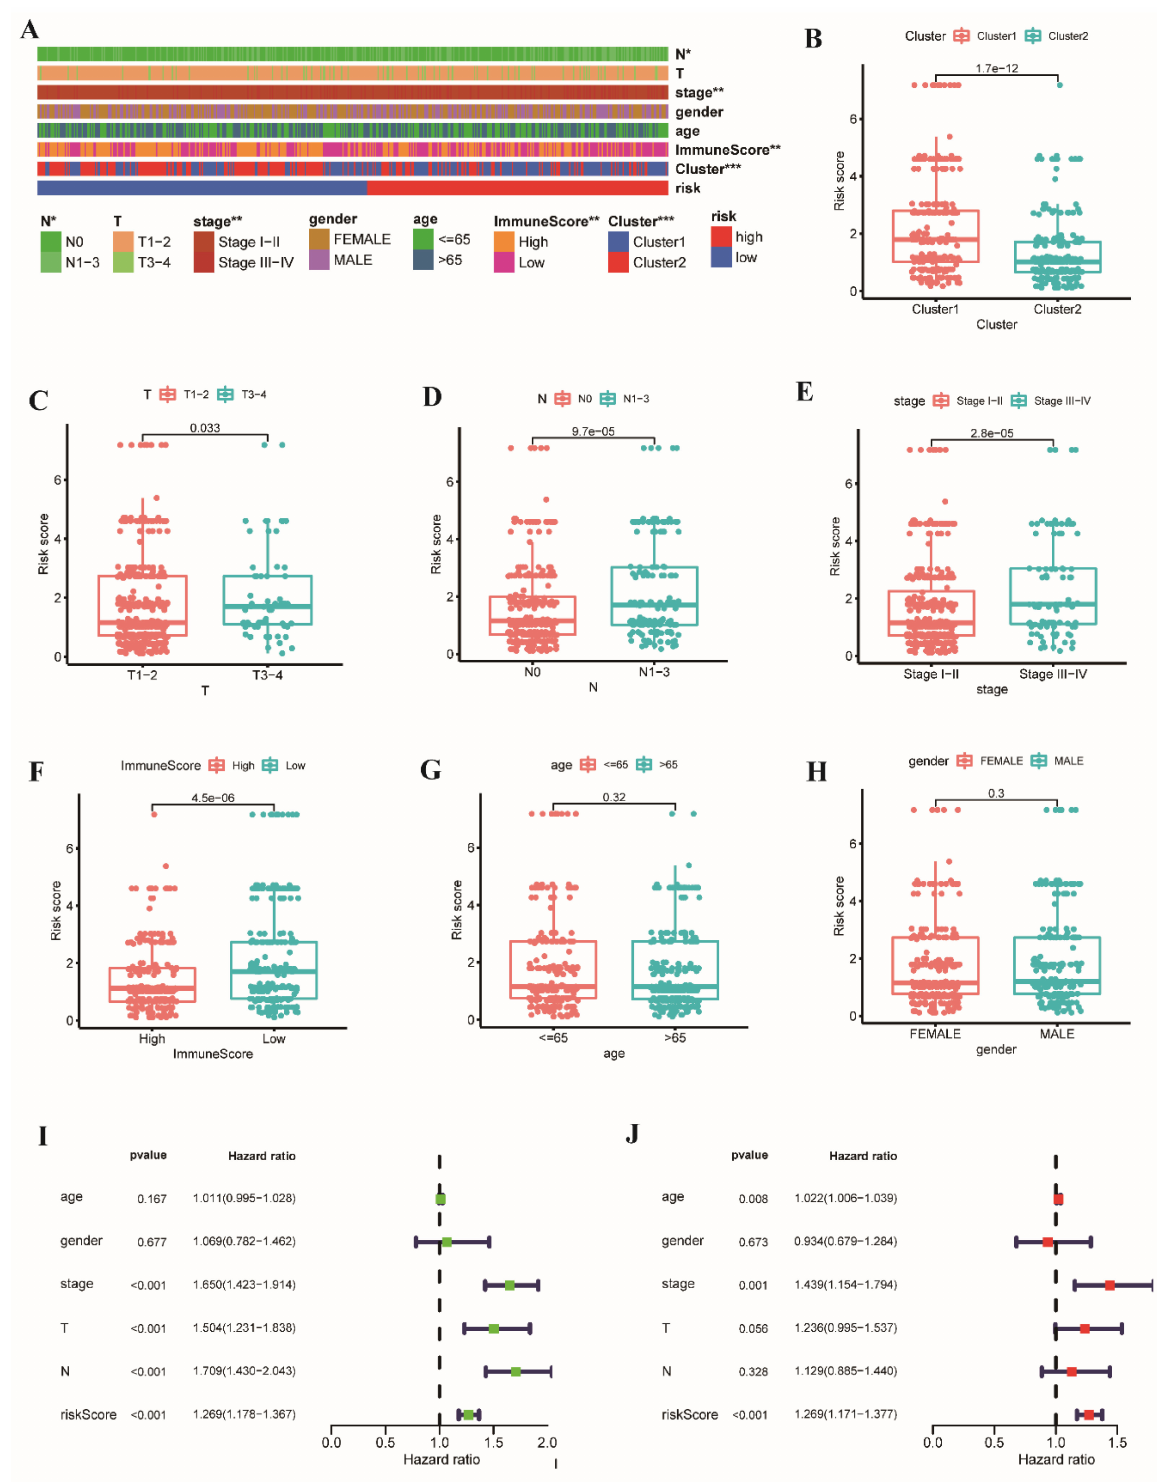
Figure 6. Correlation analysis between the clinical features and risk score of patients with LUAD in the TCGA cohort. ( A ) The heatmap of the clinical features of patients in the low- and high-risk groups. The relationship between the clinical parameters and risk score is shown in the boxplot, including ( B ) cluster, ( C ) T stage, ( D ) N stage, ( E ) TNM stage, ( F ) immune score, ( G ) age, and ( H ) gender of patients. ( I ) Univariate and ( J ) multivariate Cox analysis of signature-based risk score and other clinical features. (1.7e − 12 = 1.7 × 10 − 12 ; * p < 0.05; ** p < 0.01; *** p <